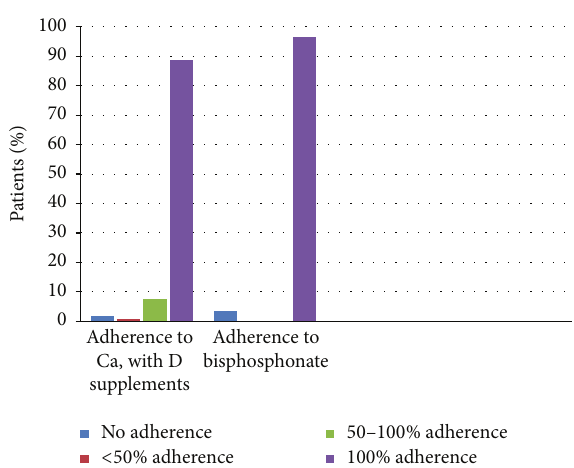
Figure 2: Level of adherence to Ca, vitamin D supplements, and bisphosphonates amongst PMR/GCA